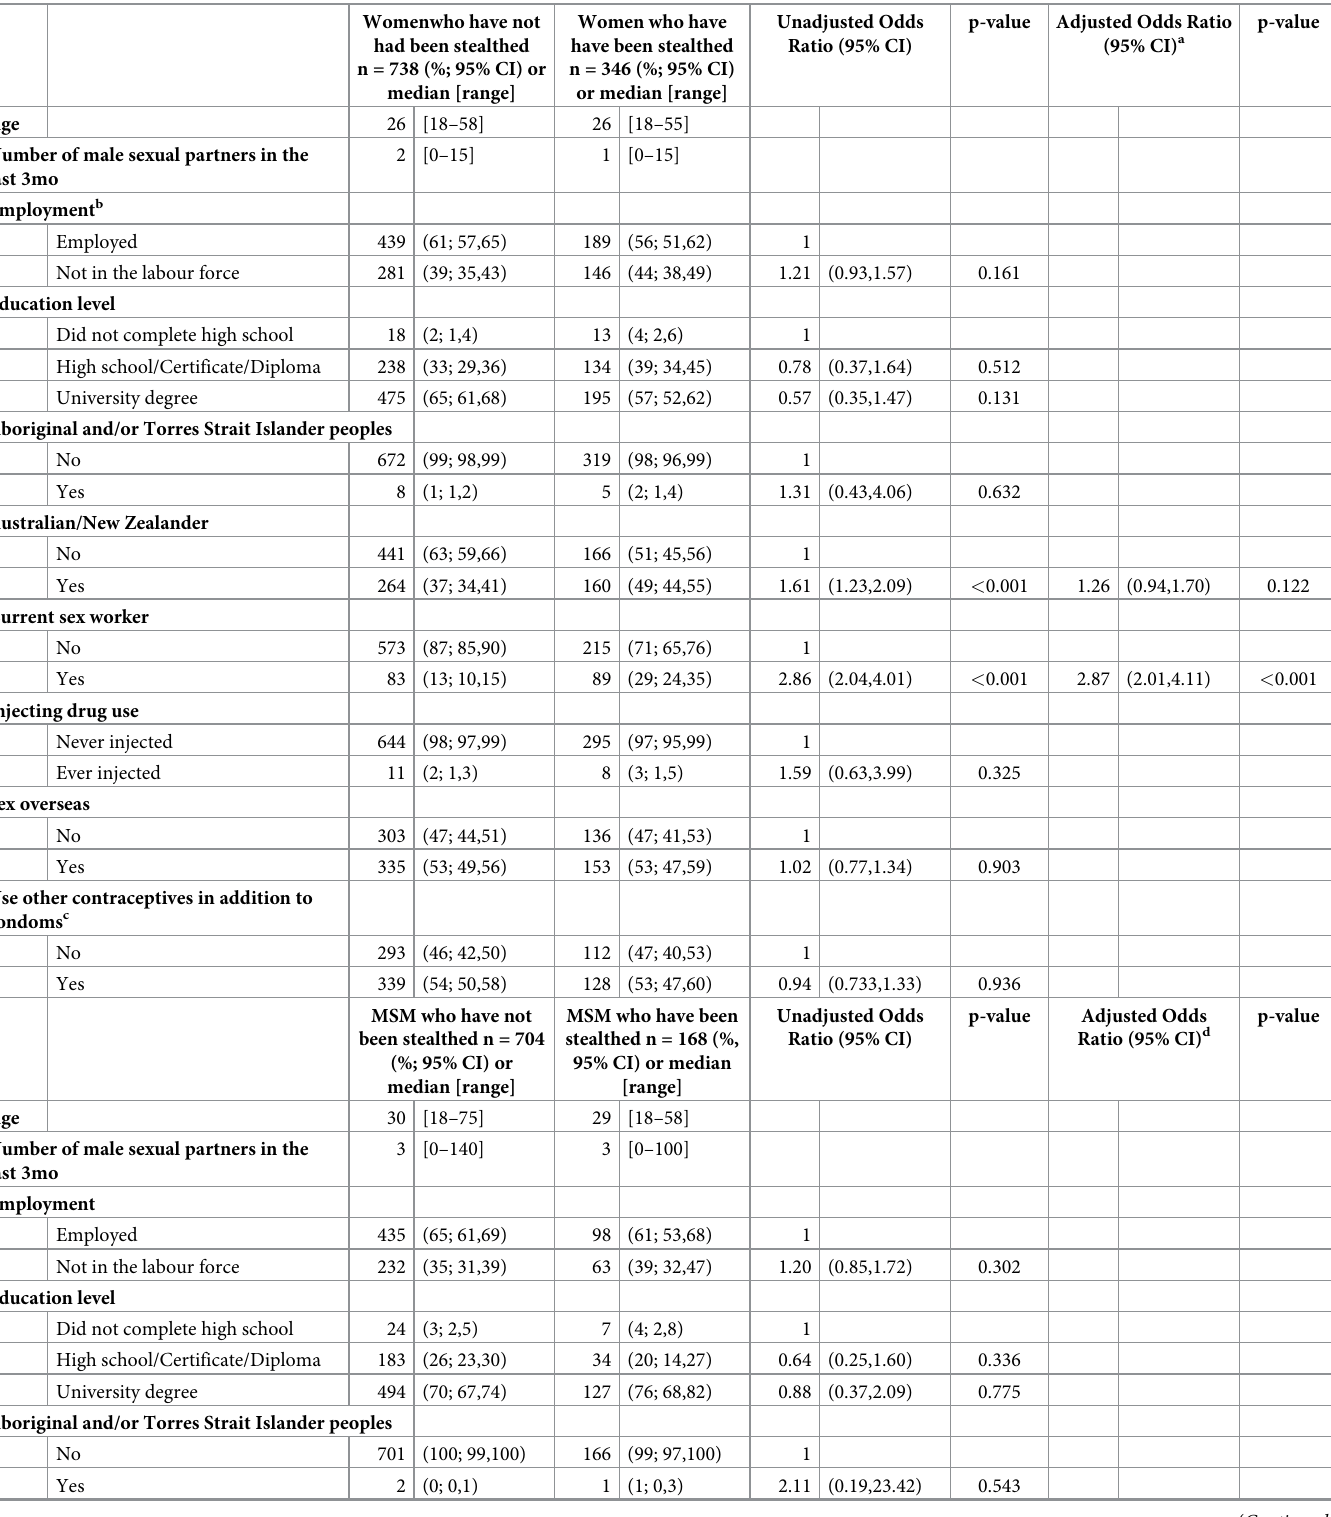
Table 3. Risk factors associated with non-consensual removal of condoms (stealthing) in patients presenting to a STI clinic (N =